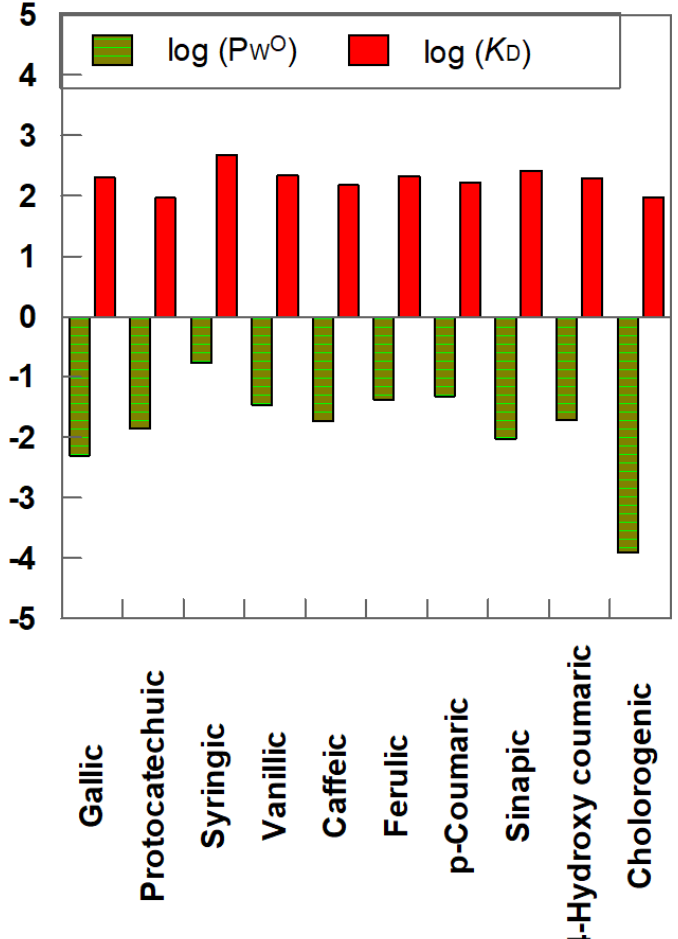
Figure 6. Values of experimentally determined association constants K D between antioxidants and SDS micelles [77] (pH = 7.4, buffered solution) and the theoretically determined partition constants P WOCT at the same pH for a series of phenolic